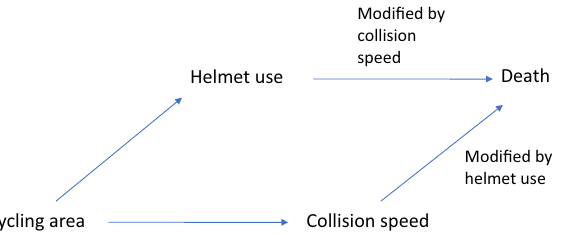
Figure 1. Directed acyclic graph of the theoretical model for the confounding or modifier effect of cycling area on the causal path between helmet use and